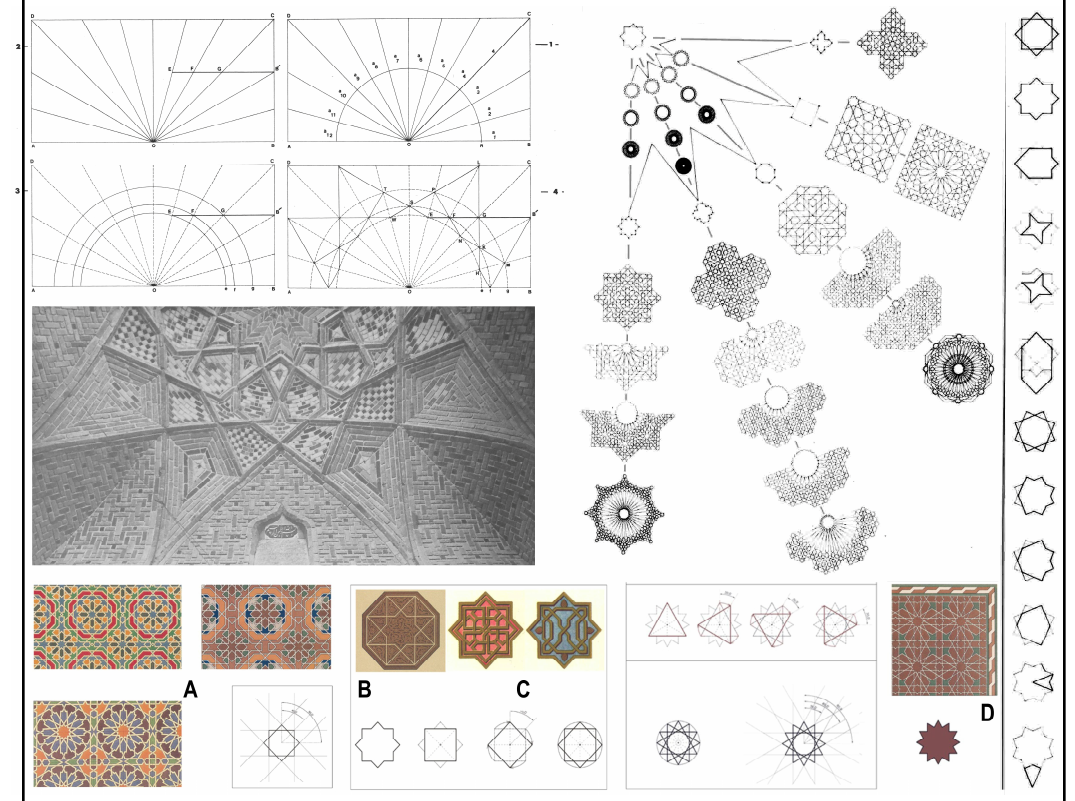
Figure 2. From Anna Marotta’s elaborations [67]: on the left, some geometric constructions to obtain complex decorations. On the right, elementary geometric matrices and subsequent composite derivations: the khatem as sememe. Starting from the basic star (the khatem or the Prophet’s ring) we can describe all the shape developments resulting from the nature of the star’s rotation on its center. The big stars are formed by a rose composed by petals regularly arranged around a center, externally bounded by a polygonal line called the belt; outside this belt, the star joins a composition of simpler motifs, structured to form a set that can be repeated for symmetry. Because the star joins harmoniously outside, it must have the privileged direction of the khatem , so the number of petals will be a multiple of eight. Below, from left to right, Mihrab of the Cheykhoun Mosque ( A ). In the center, Thelay Abou-Rezyq Mosque, Il Cairo ( B ) and Alhambra, Granada ( C ); On the right, A. Racinet, Handbook of Ornaments in Color Moorish art, Table 37, No. 1, p. 81, vol. III, Hardcover, 1978 ( D